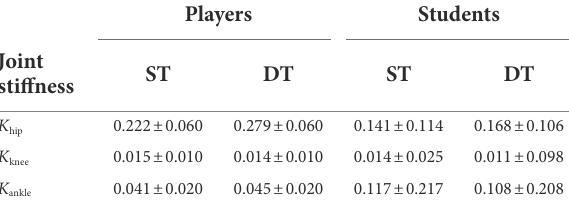
TABLE 3 Changes in joint stiffness in the two groups under the two tasks (mean ±